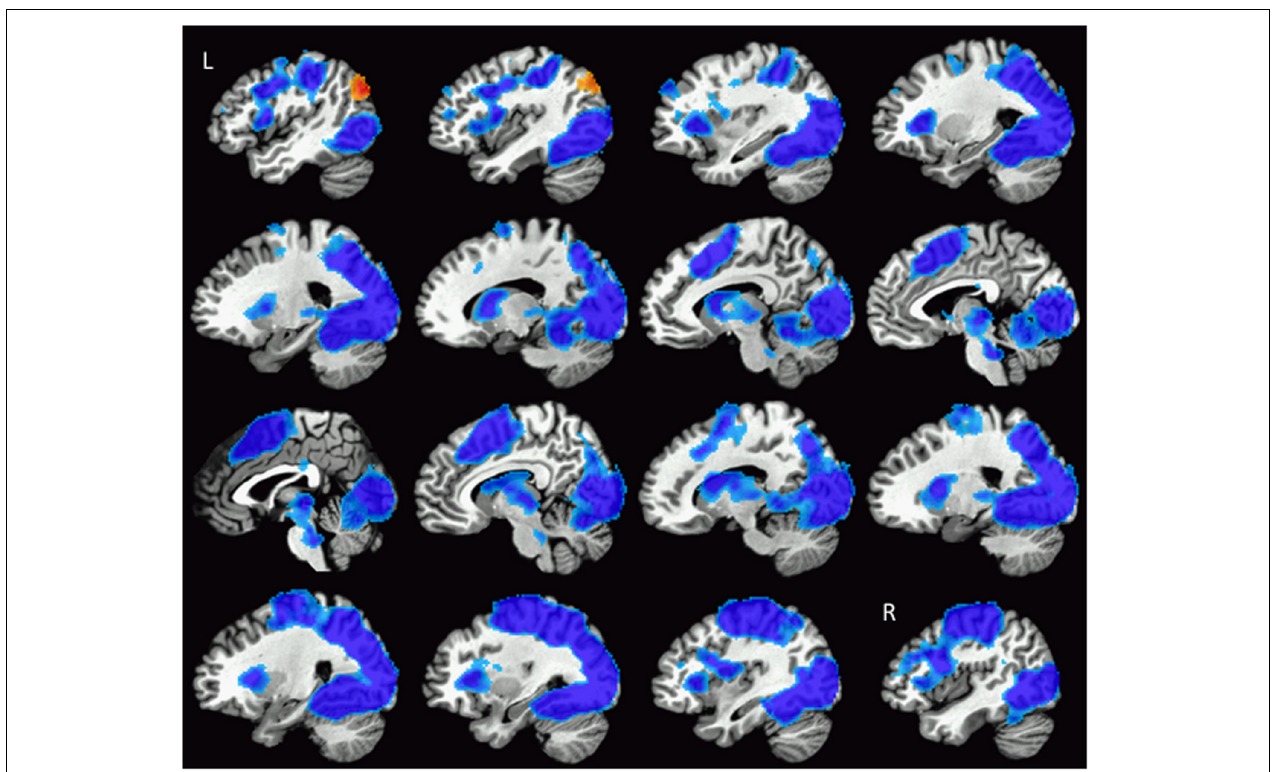
FIGURE 3 | Illustration of the widespread pattern of changes in activation during texture categorisation following training. Regions showing reduced activity (blue colours) included bilateral aspects of the occipital cortex, IPS, primary and somatosensory cortices, SMA, dACC, DLPFC, insula, caudate, and putamen. The left MOC was the only region to show increased activation after training (red colours). Images are arranged such that the first slice at the top left of the figure is located in the left hemisphere (L), progressing rightward through the brain until the last slice in the right hemisphere (R) shown on the bottom right of the figure.